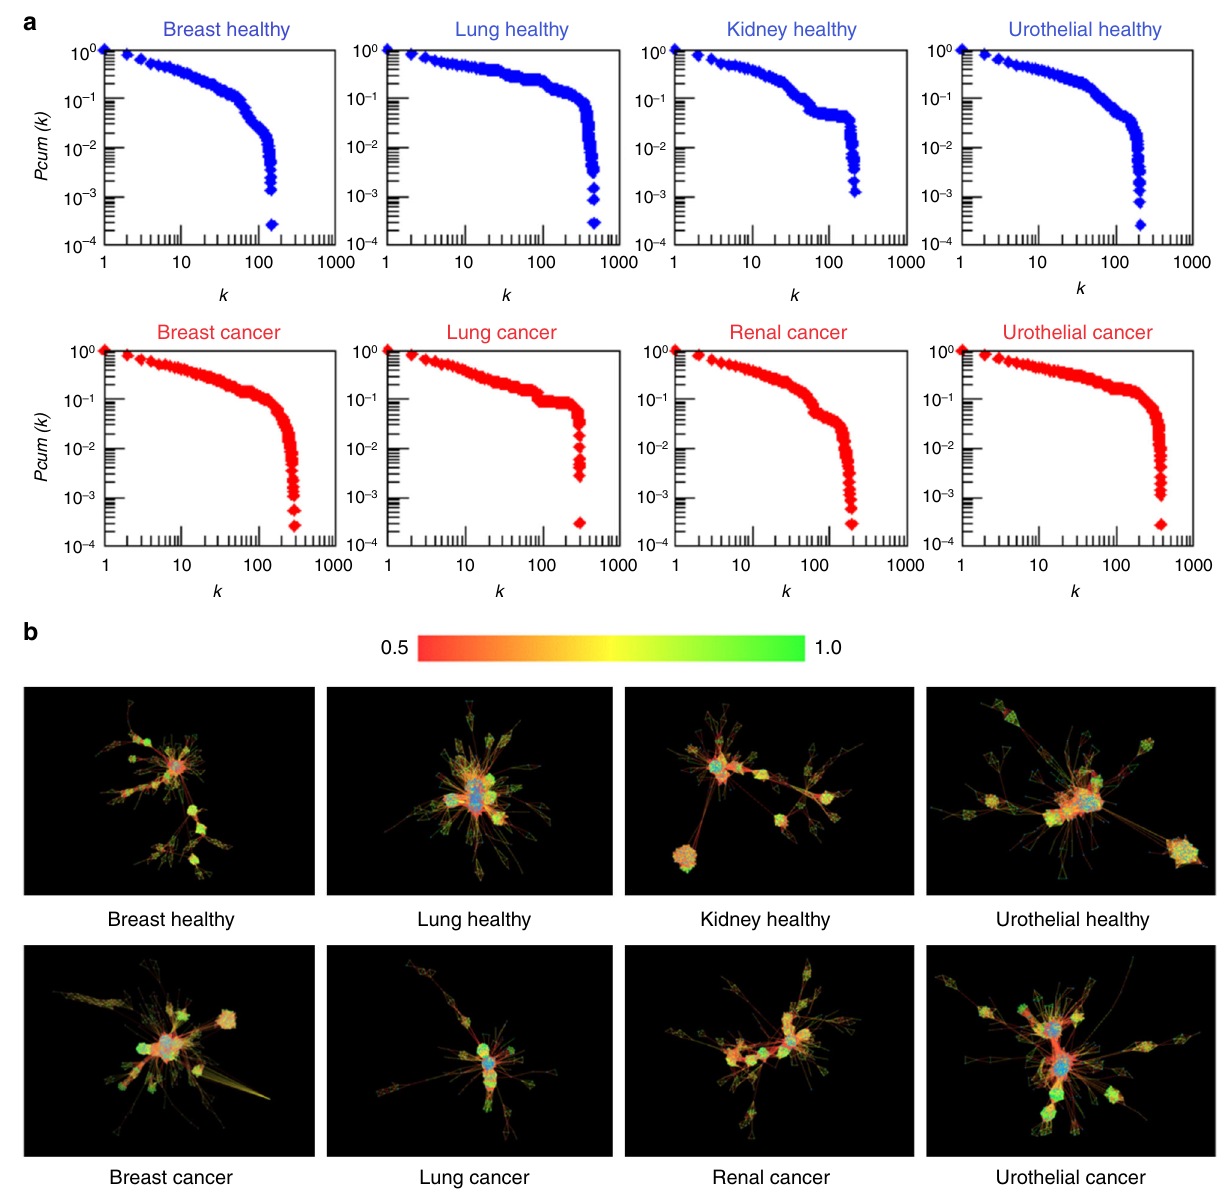
Fig. 3 Topology of healthy and cancer networks. a Cumulative degree distributions of healthy and cancer high fl ux correlation networks. b Visual representation of high fl ux correlation networks; the edge colour represents the fl ux correlation ranging from 0.5 (red) to 1.0 (green)